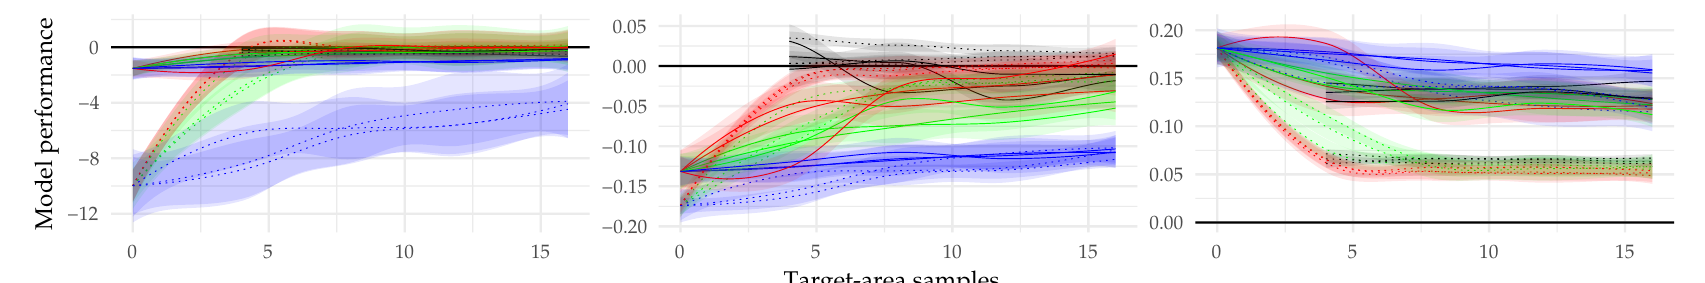
Figure 9. The influence of calibration spiking, weighing of the spiking samples, and removal of library spectra from the training dataset on partial least squares 2 regression (PLSR2) model performances. Only scenarios with basic and no further spectra pre-processing are included. Each line represents one combination of levels of the remaining experimental variables: leverage sampling strategy and predictive model family. A mean across 10 test datasets is drawn along with its 95% confidence